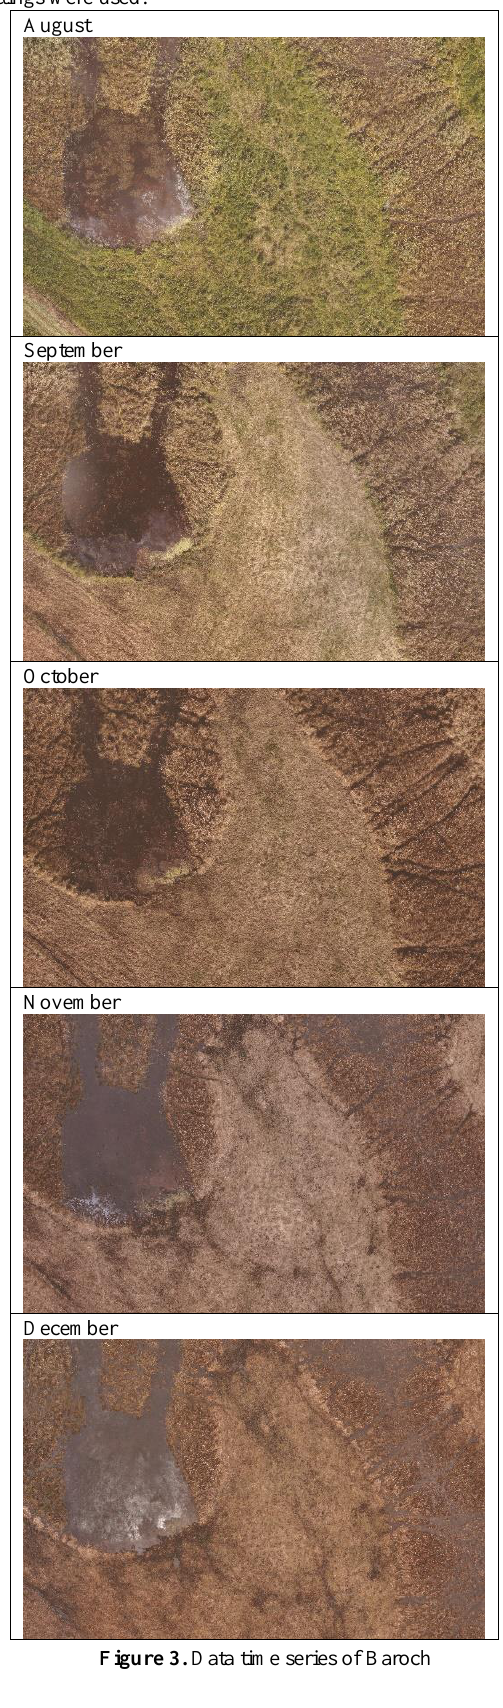
Figure 3. Data time series of